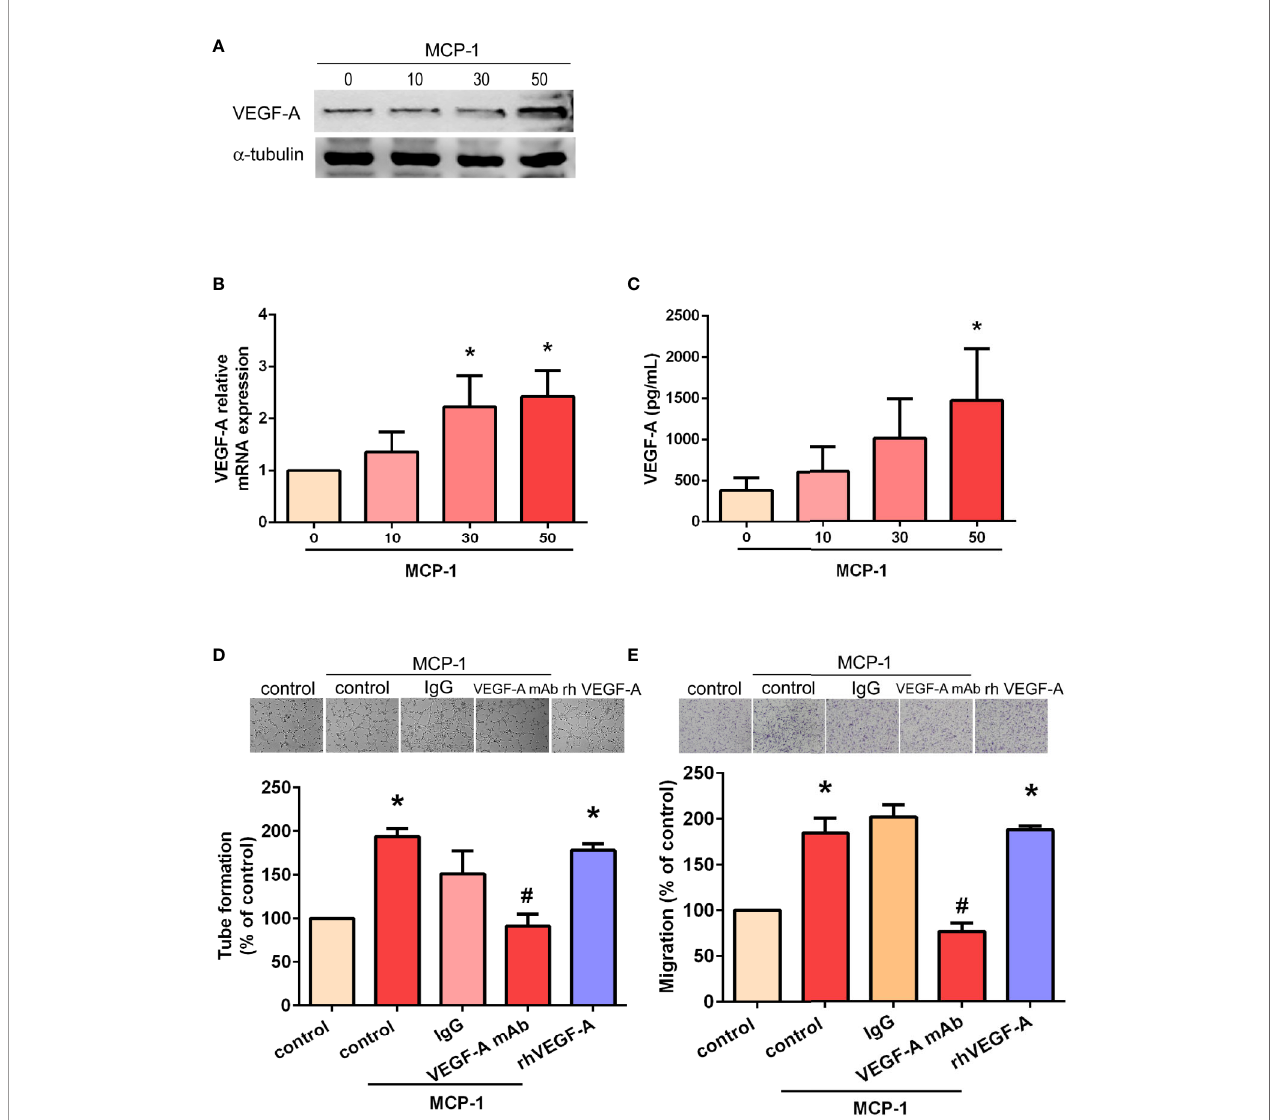
FIGURE 2 | MCP-1 promotes human OSCC cell angiogenesis through the VEGF-A-dependent pathway. Cells were incubated with MCP-1 (0 – 50 ng/ml) for 24 h and VEGF-A expression was determined by Western blot (A) , RT-qPCR (B) , and ELISA assays (C) . The CM was collected and used to treat the EPCs for 24 h. We used the tube formation assay to examine capillary-like structure formation (D) and the Transwell assay to examine cell migration (E) . * p < 0.05 compared with controls; # p < 0.05 compared with MCP-1 – treated controls. Each experimental procedure was independently repeated three times, with similar